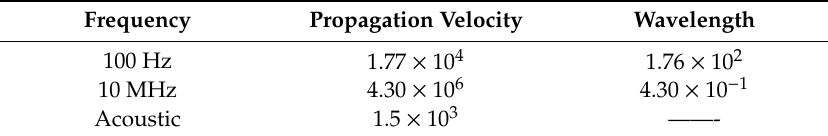
Table 4. Performance of electromagnetic waves in seawater [40].